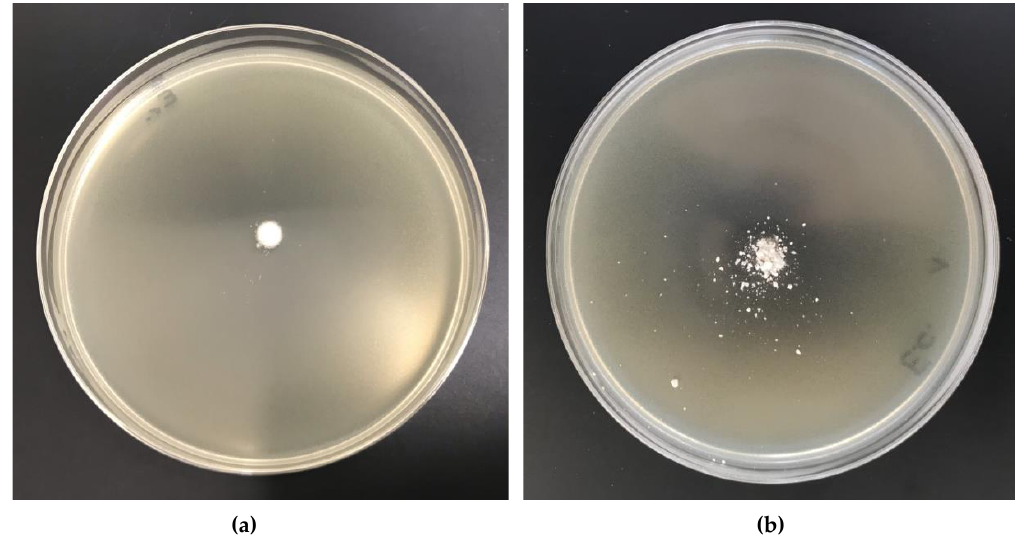
Figure 17. The Cell- O 6 -P(O)(O − )-H × Cu 2+ complexes antimicrobial activity tests against Escherichia Coli. Inhibition zones of bacterial growth on Petri dishes: ( a ) Cell- O 6 -P(O)(OH)-H(48 h), ( b ) Cell- O 6 -P(O)(OH)-H(48 h) × Cu 2+ .